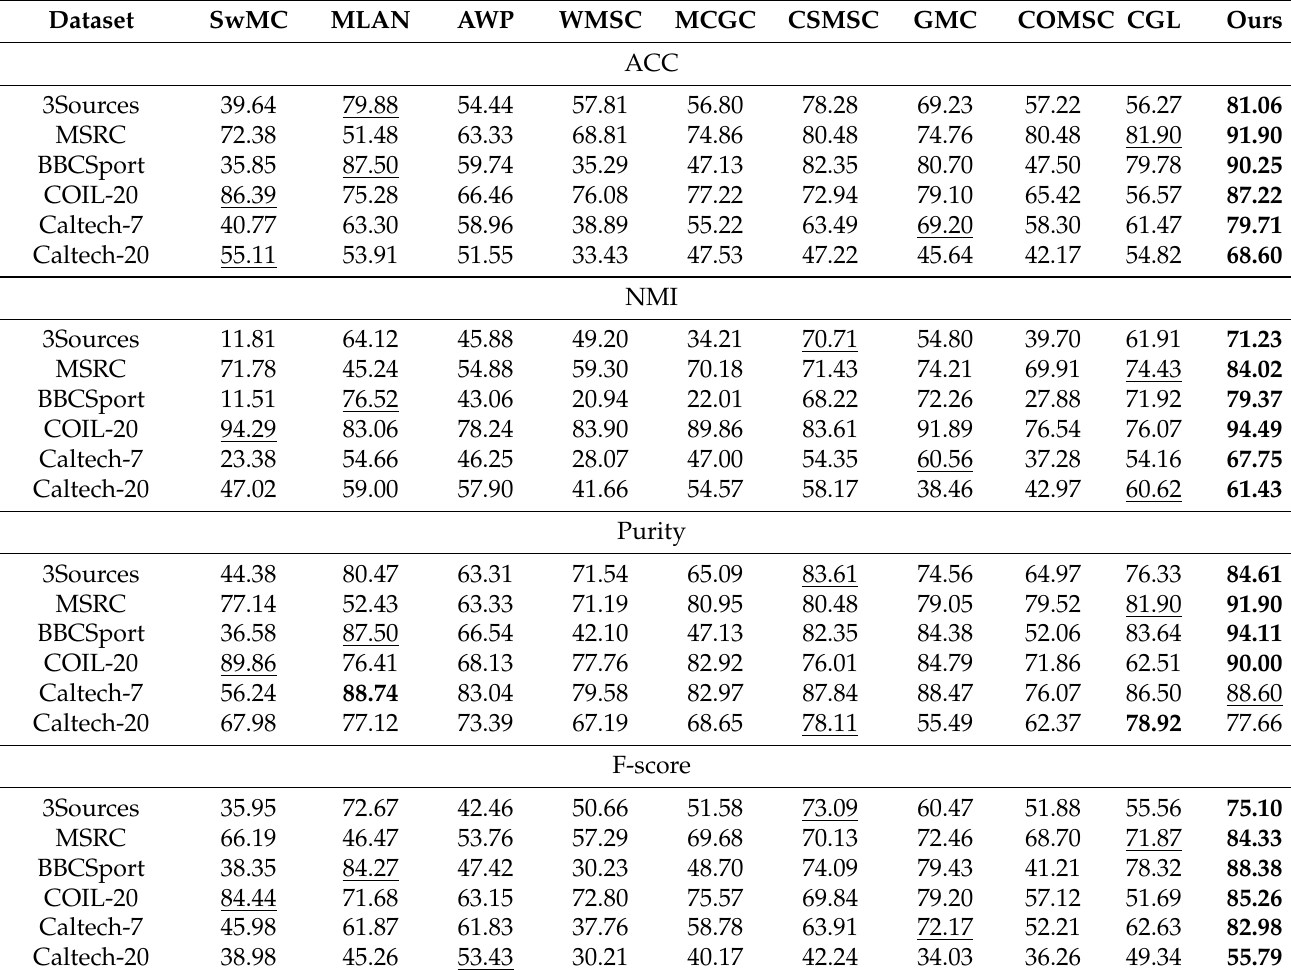
Table 3. Clustering results of all methods on different datasets (%). The best performance is bolded , and the second best performance is